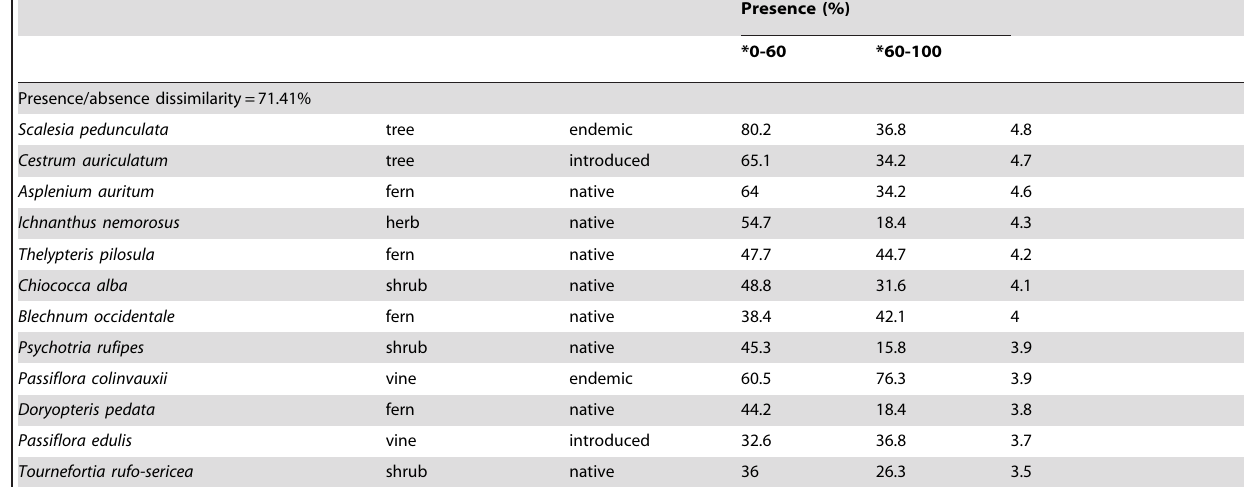
Table 2. Summary of the soil physical characteristics between niveus categories.